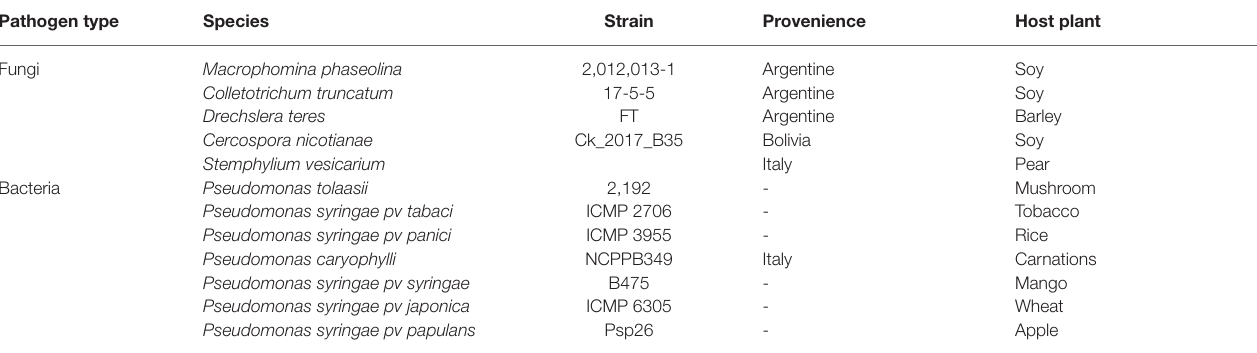
TABLE 1 | List of the phytopathogenic fungi and bacteria used in this